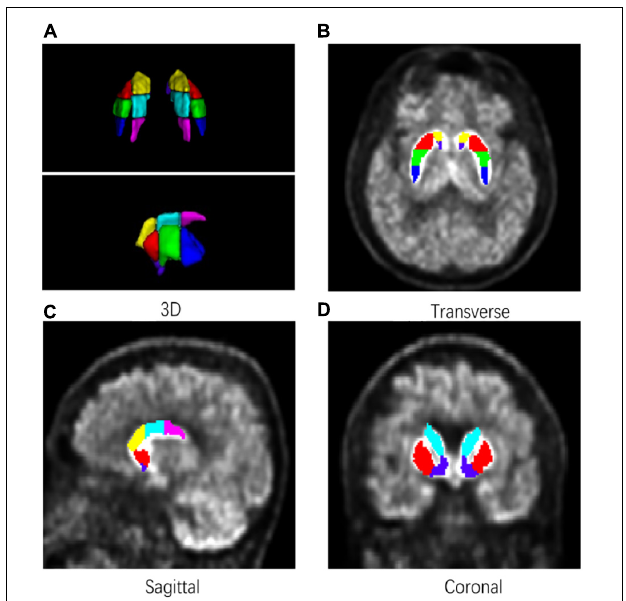
FIGURE 2 | An example of a subregion segmentation result. Bilateral putamen and caudate were divided into three equal parts in length. (A) 3D. (B) Transverse. (C) Sagittal. (D)